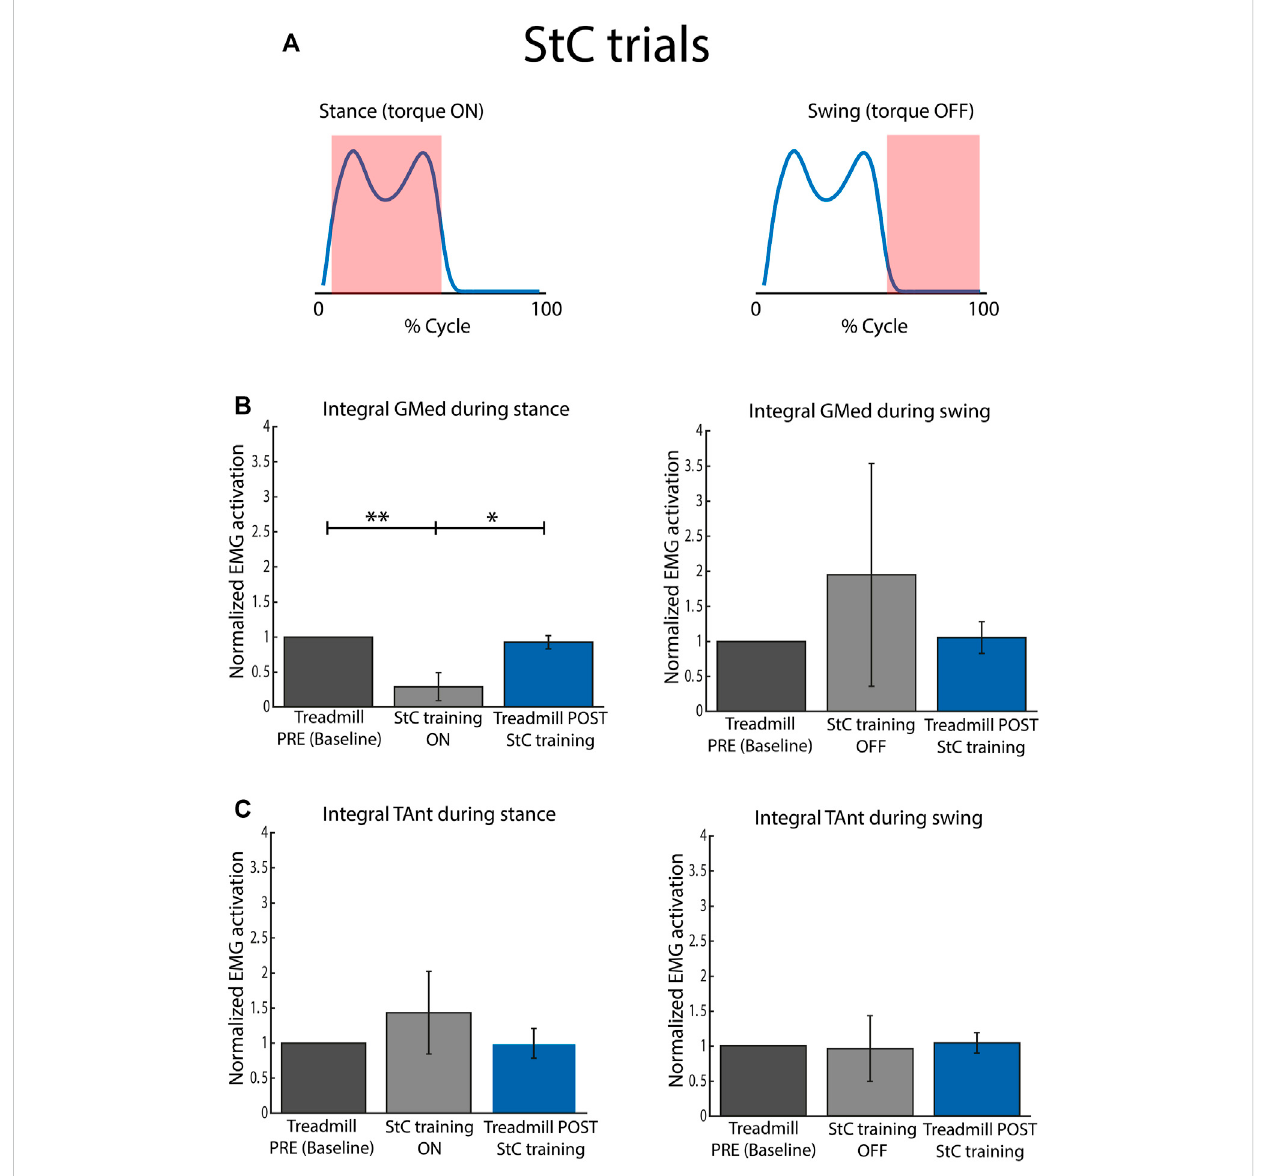
FIGURE 6 Normalized EMG activation across subjects for StC and treadmill (PRE and POST StC training) trials. (A) Torque pro fi le delivered during stance and swing (no disturbances) under StC disturbances. (B) Activation of GMed during stance (left panel) and swing (right panel), normalized to the baseline, i.e. , TreadmillPRE. (C) ActivationofTAntduringstance(leftpanel)andswing(rightpanel), normalizedtothebaseline, i.e. ,TreadmillPRE.Barsrepresentmean and standard deviation of the group. p < 0.05*; p <